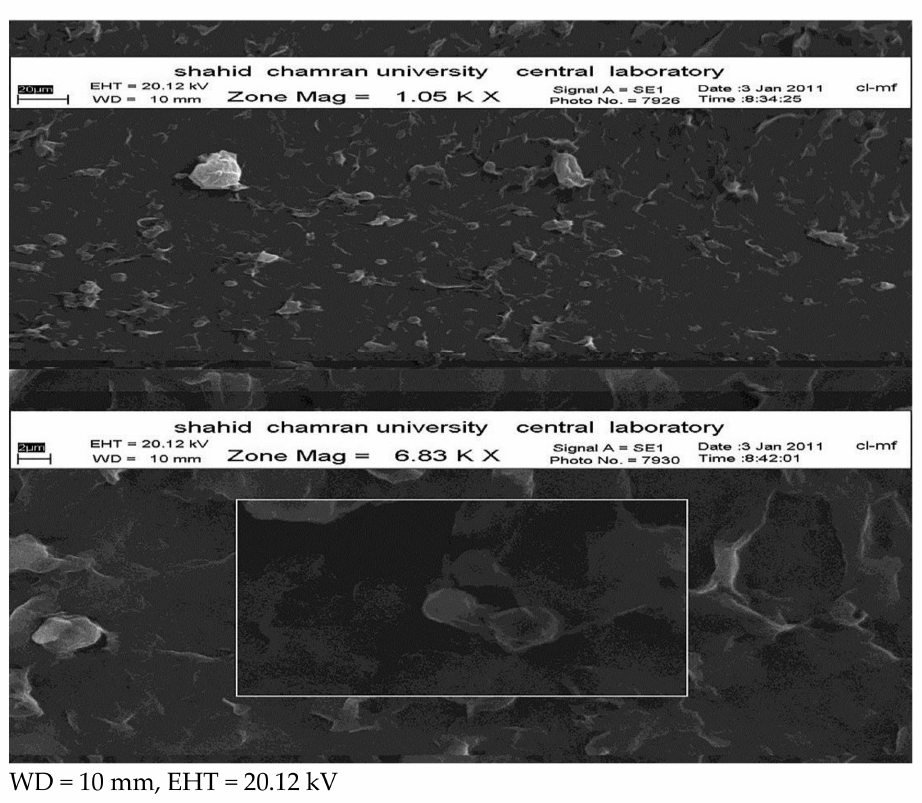
Figure 2. Scanning Electron Microscopy SEM imaging for lipid nanoparticles containing propranolol